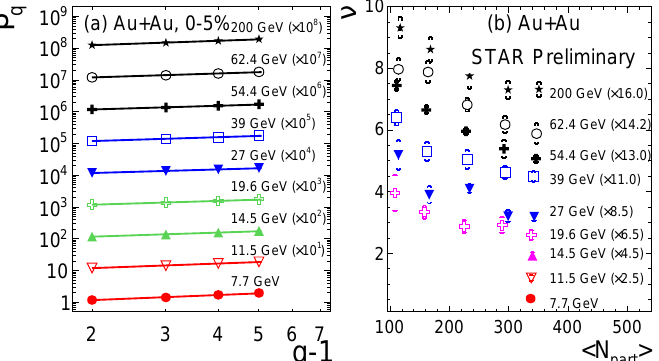
Figure 3: (a) β (q = 3-6) as a function of q-1 in most central Au + Au collisions at q (cid:112) = 7.7-200 GeV. (b) ν as a function of 〈 N s NN